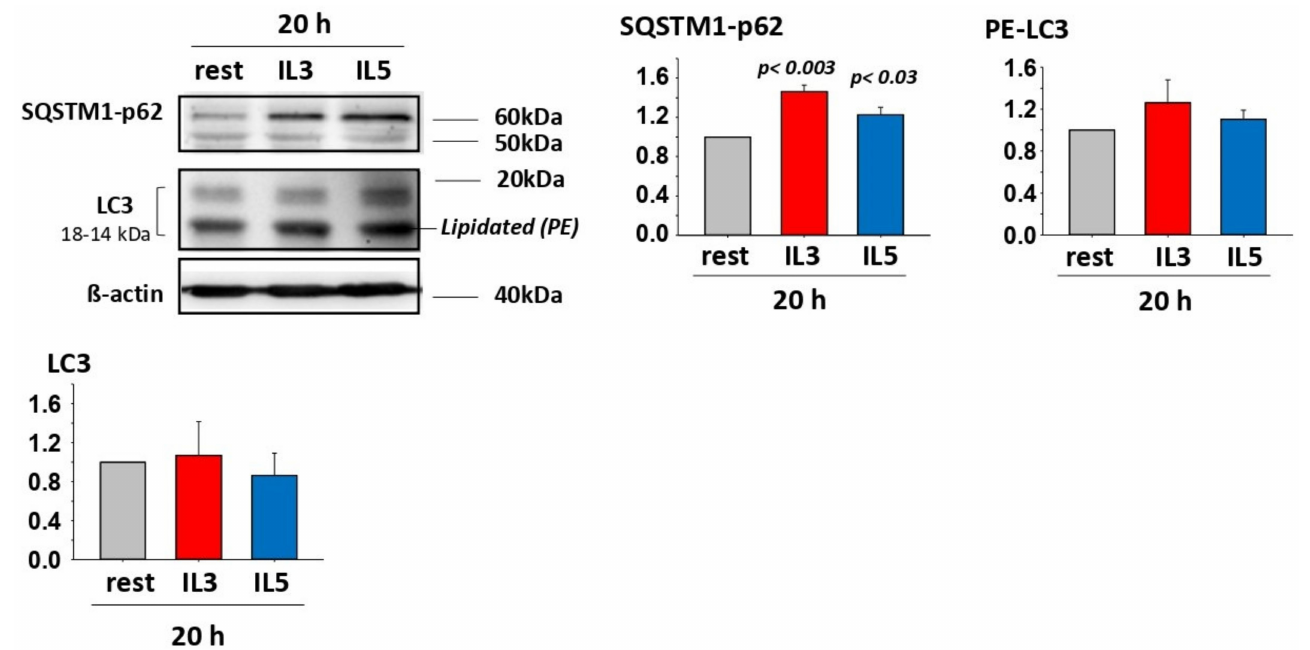
Figure 2. Primed eosinophils produce SQSTM1-p62, LC3 and lipidated-LC3 (PE-LC3). Blood eosinophils were cultured without cytokine (rest) or were primed with either IL3 (2 ng/mL) or IL5 (2 ng/mL) for 20 h. A representative Western blot is shown and graphs show the average ± SEM of the ratio with β -actin from 3 experiments using 3 different donors. The ratio for rest was fixed at 1. SQSTM1-p62 is increased by cytokine priming while LC3 and PE-LC3 were not changed. One-way ANOVA was performed and p values compared to rest for SQSTM1-p62 are